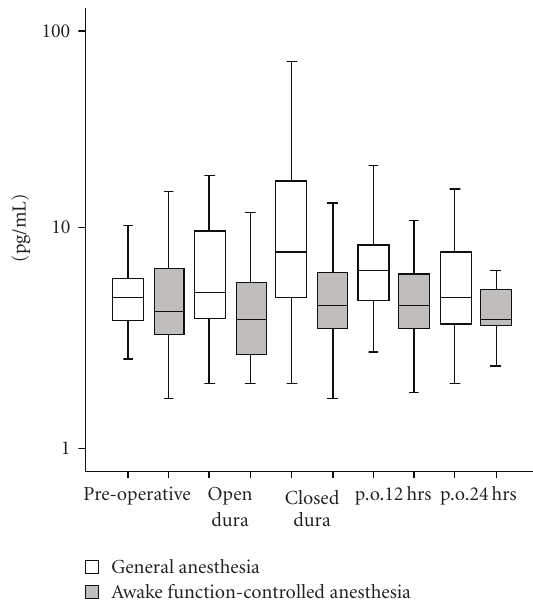
Figure 2: Box plots of plasma IL-8 levels . IL-8 levels do not significantly change throughout time for both experimental groups. No significant di ff erence in plasma IL-8 levels is found between groups.